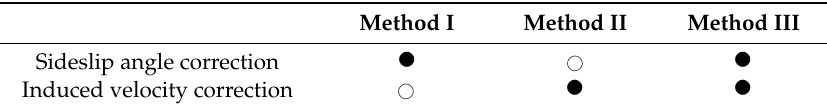
Table 8. Computation methods of angle of attack.